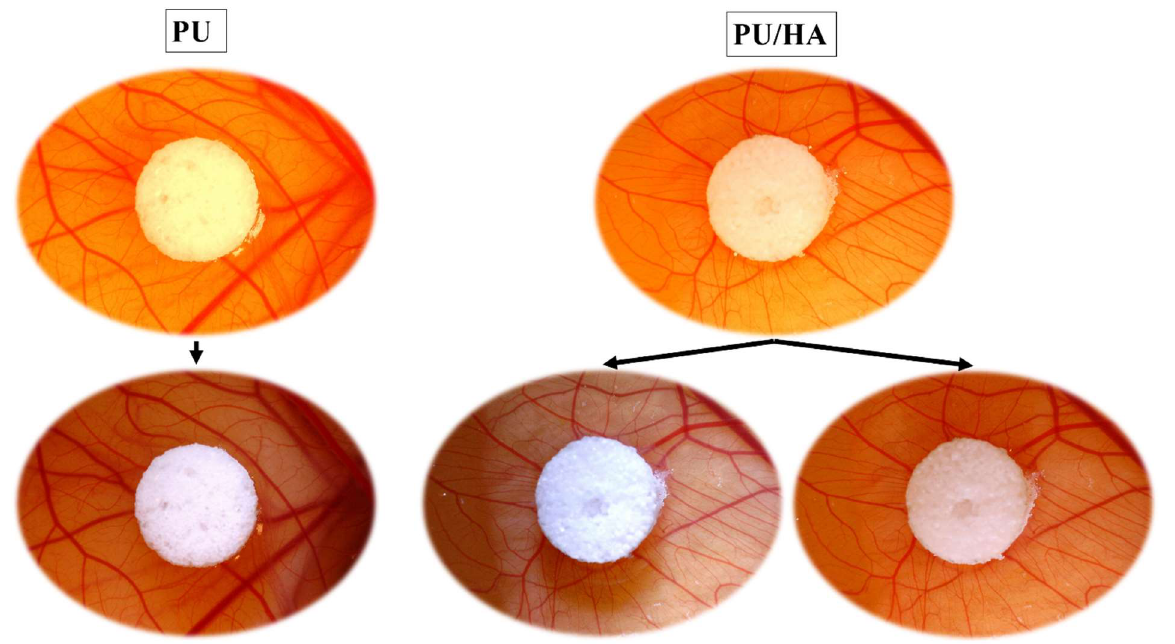
Figure 14. PU and PU/HA scaffold in the CAM essay to show comparison of new blood vessel occurrence with the scaffolds.